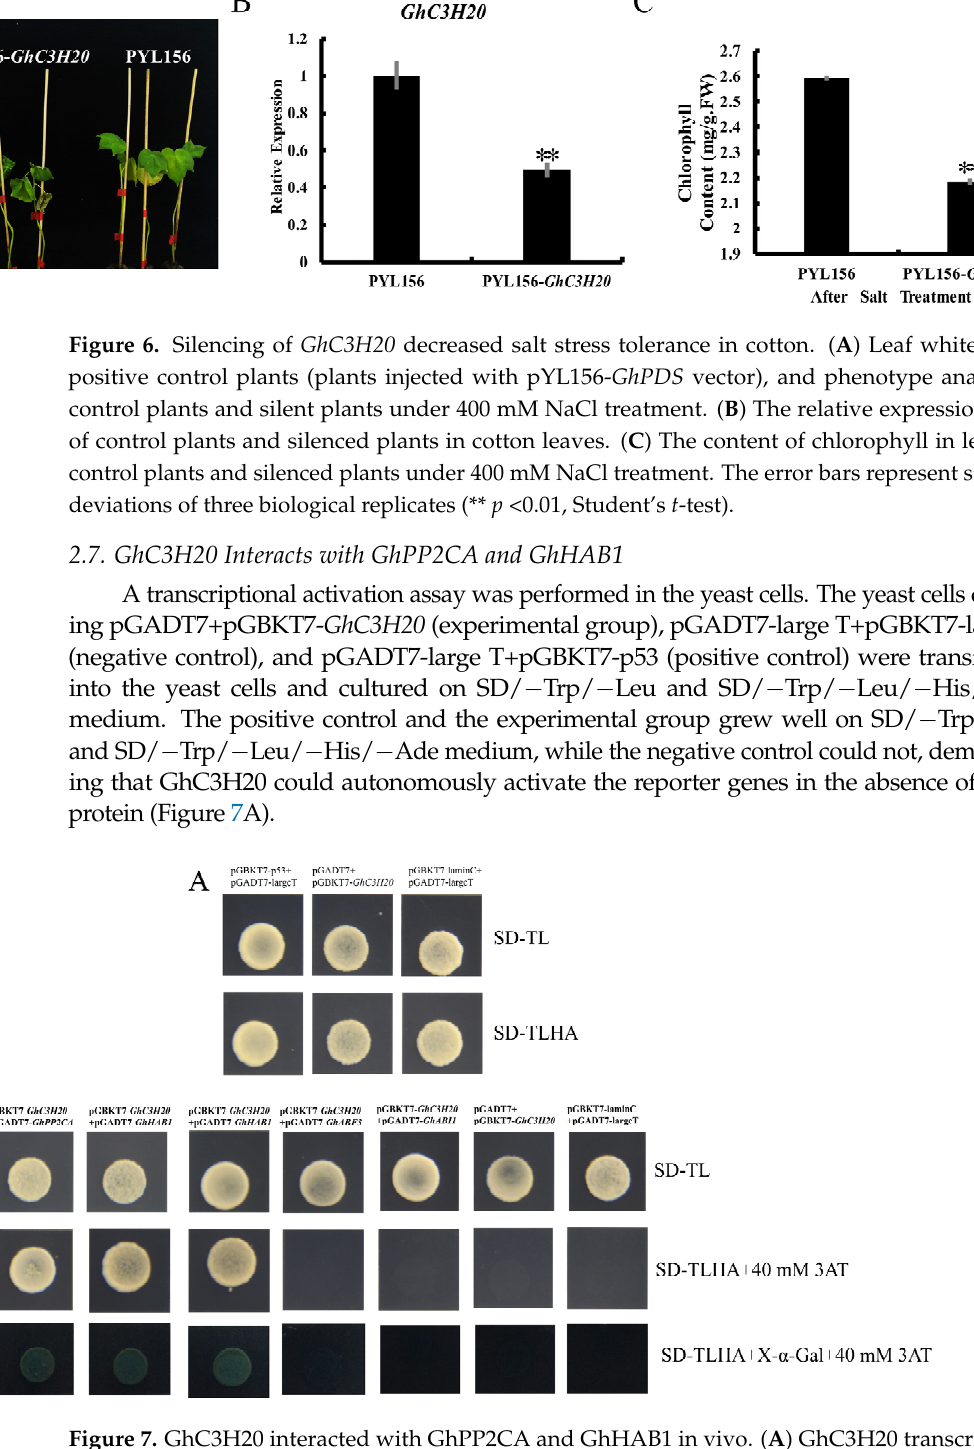
Figure 7. GhC3H20 interacted with GhPP2CA and GhHAB1 in vivo. ( A ) GhC3H20 transcriptional activation assay. ( B ) GhC3H20 interacted with GhPP2CA and GhHAB1 in yeast cells .